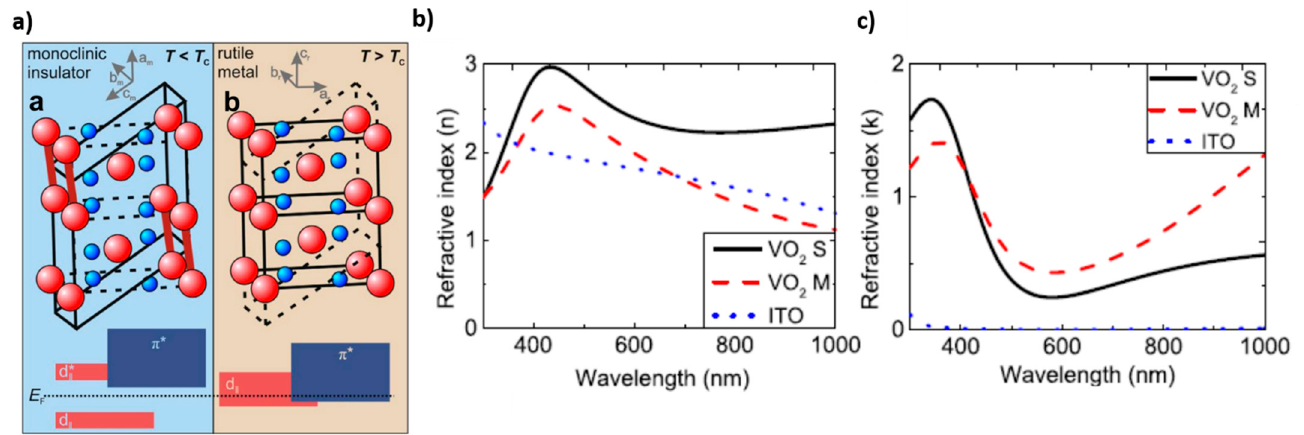
Figure 2. ( a ) Insulator to metal phase-change transition in VO 2 [23]; ( b ) variation in the visible range of the real part of the refractive index of VO 2 upon phase transition [24]; ( c ) variation in the visible range of the imaginary ( k ) part of the refractive index of VO 2 upon phase transition [24]. Reproduced from Refs. [23,24] with permission from Nature Springer and IOP publishing.